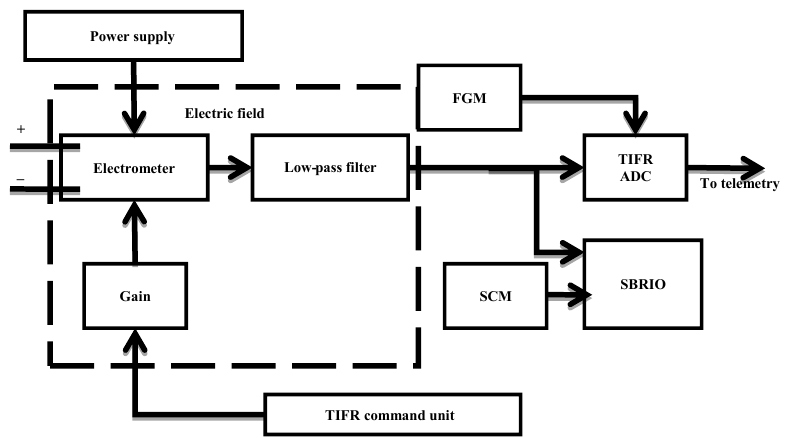
Figure 3. A block diagram of the experimental setup of the BEENS